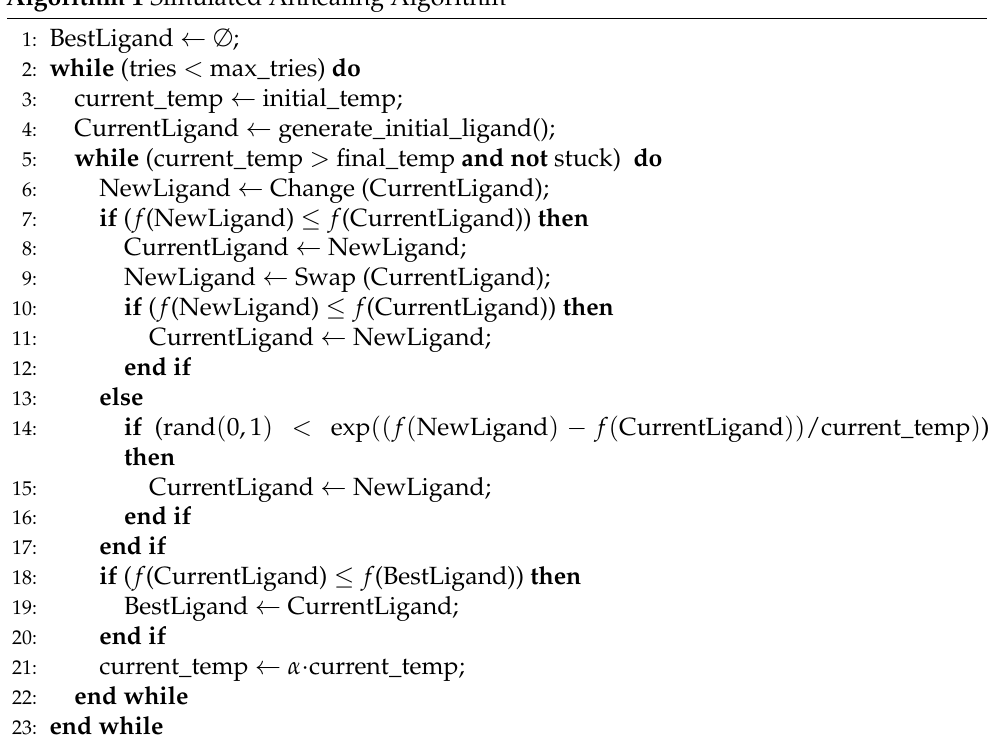
Algorithm 1 Simulated Annealing